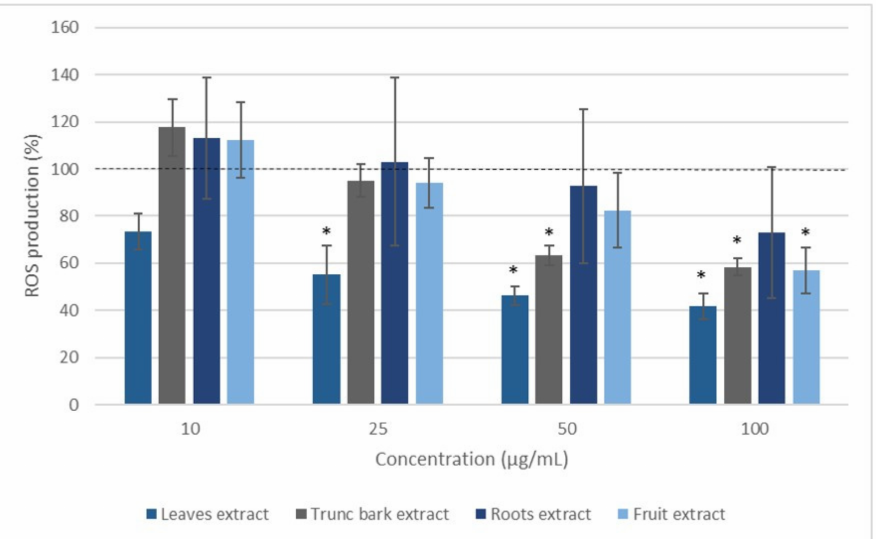
Figure 5. Effect of Vitex madiensis extracts on ROS production of blood leukocytes stimulated with PMA for 2 h. Values are expressed as percentage of the Control (cells incubated with PMA and without extract). * p < 0.05, compared with Control normalized as 100% (dotted